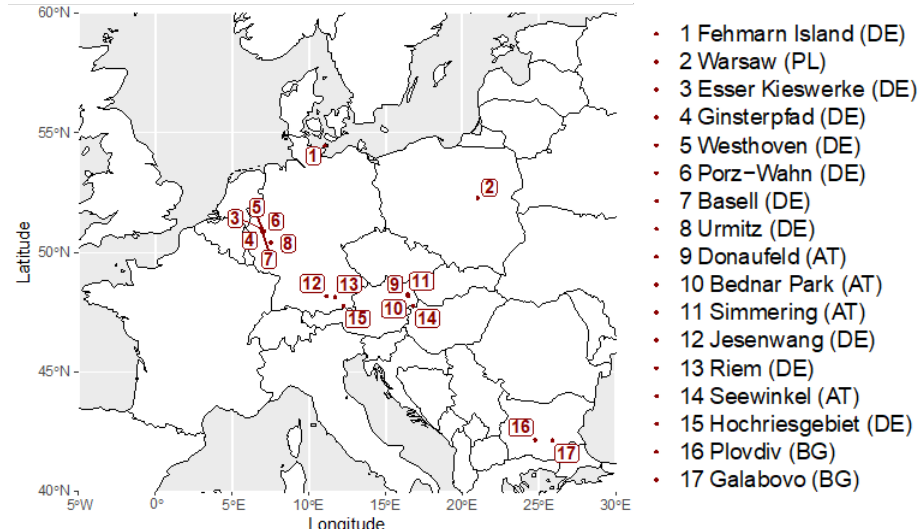
Figure 1. Locations of green toad populations in Europe included in this study.